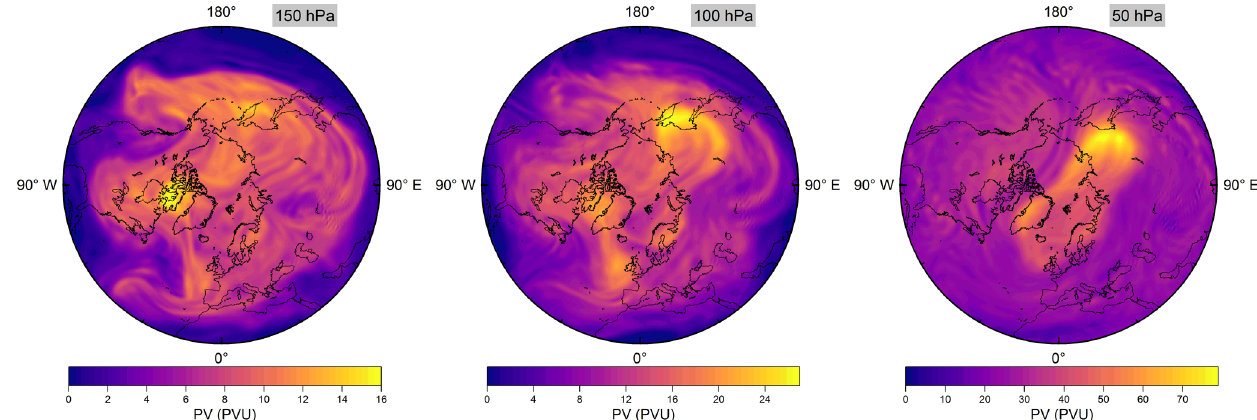
Figure 4. Northern Hemisphere potential vorticity (PV) maps from ECMWF reanalysis at 150, 100 and 50hPa on 26 February 2016 at 12:00UTC. Note the different colour scales in each panel.